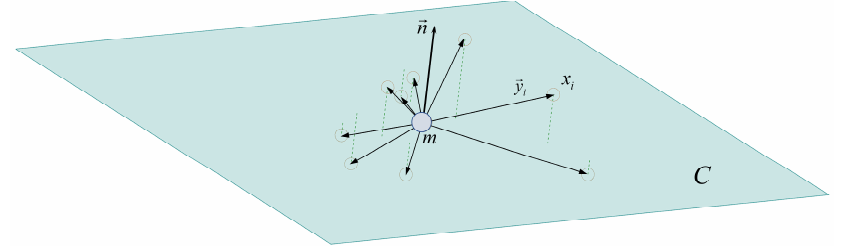
Figure 3. Fitting plane by PCA.